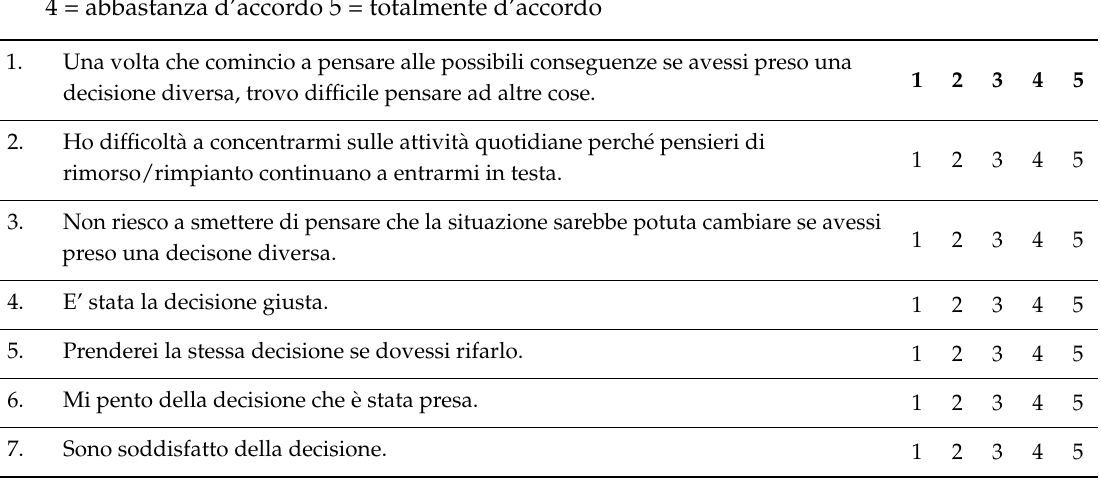
Una volta che comincio a pensare alle possibili conseguenze se avessi preso una decisione diversa, trovo difficile pensare ad altre